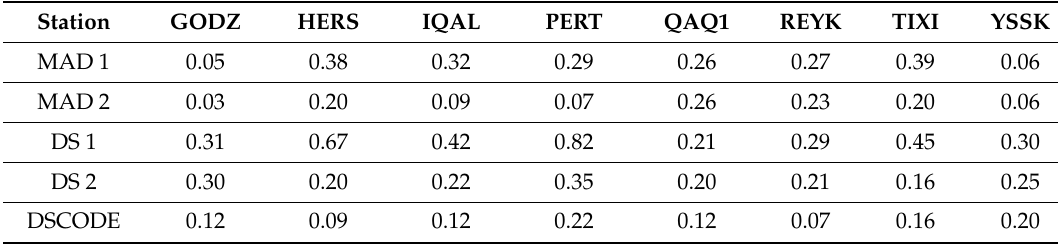
Table 2. Monthly mean di ff erence with respect to CODE receiver DCBs (MAD) and day scatter (DS) of eight sample stations during the second half of January 2011. Note that the number denotes di ff erent cases. Case 1 represents the results using all stations and case 2 represents the results using reference stations. Unit: